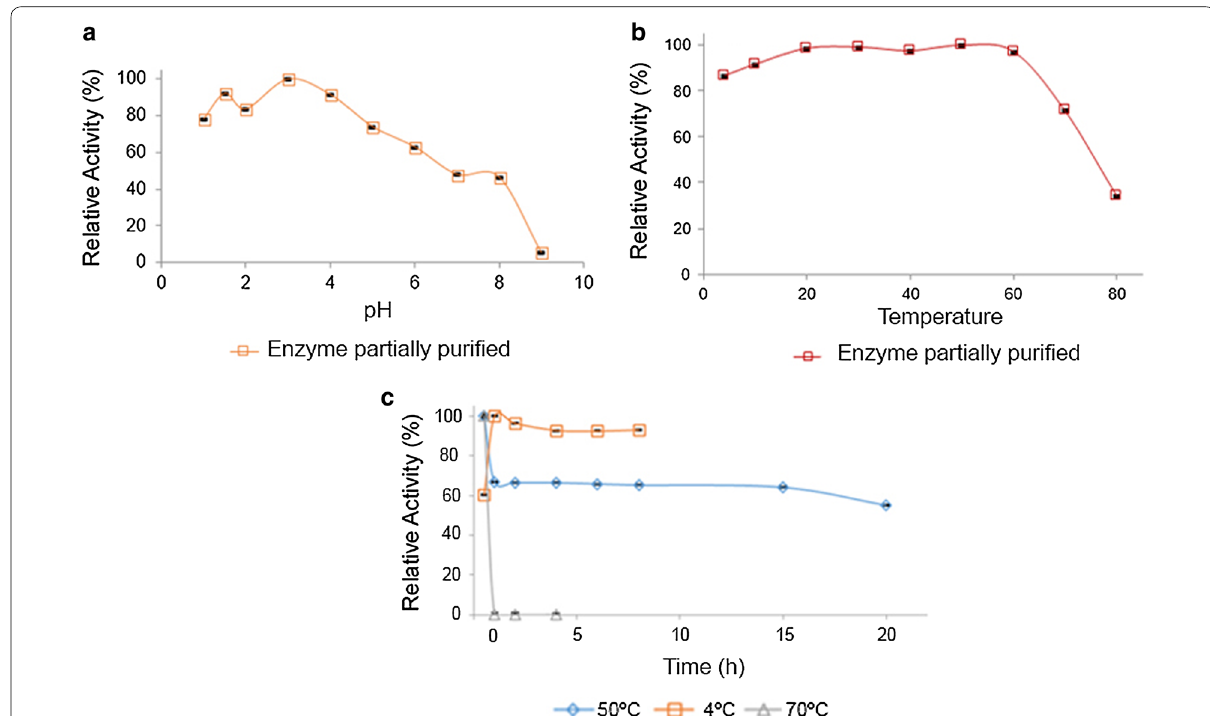
Fig. 5 a Activity versus pH profiles of the partially purified β‑galactosidase. Enzyme activity is plotted as a % value relative to the activity displayed at the enzyme’s optimum pH. Error bars indicate the standard deviation of the measured data values from the mean, n temperature profiles of the partially purified β‑galactosidase. Enzyme activity is plotted as a % value relative to the activity displayed at the enzyme’s optimum temperature. Error bars indicate the standard deviation of the measured data values from the mean, n β‑galactosidase partially purified from A. niger at 4 °C, 50 °C and 70 °C